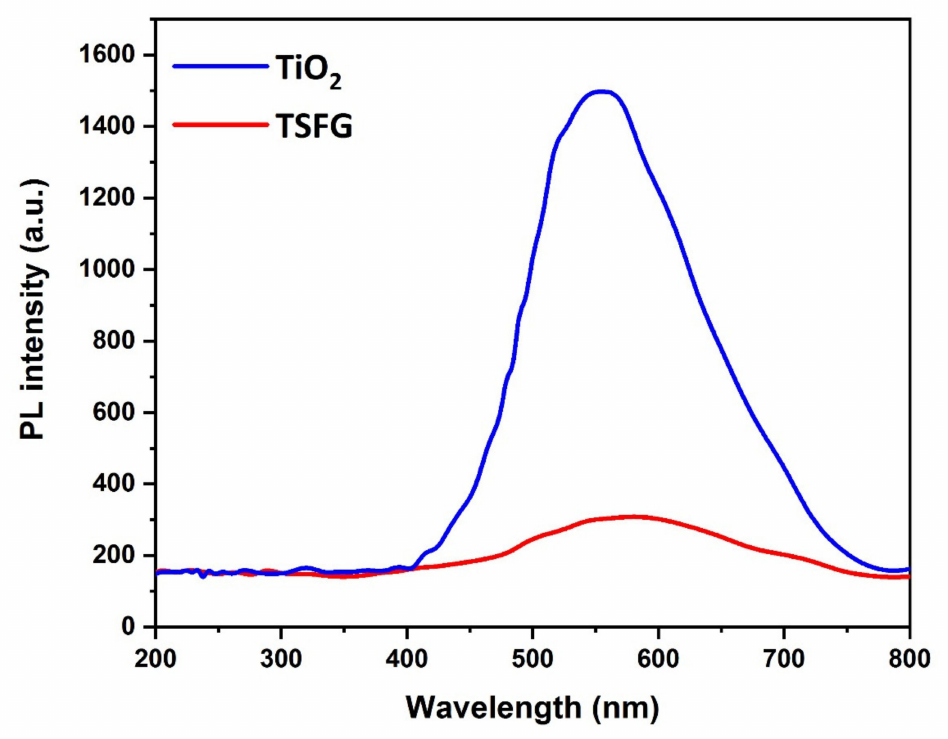
Figure 9. PL spectra of TiO 2 and TSFG